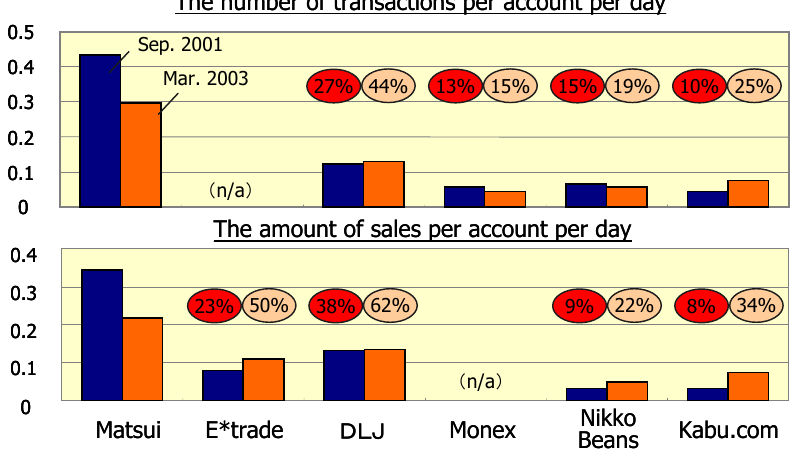
Figure 5. Number and Sales of Contract Per